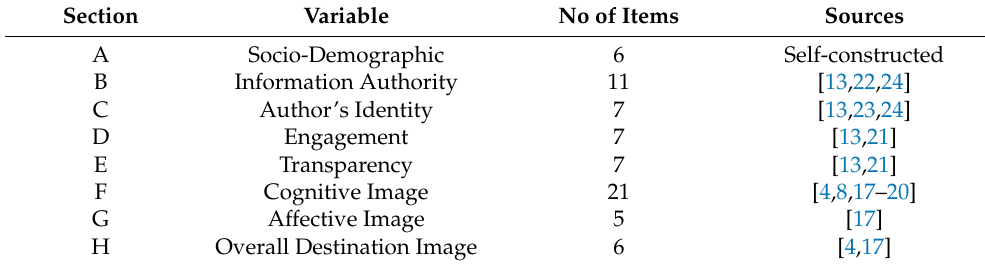
Table 1. Instrument